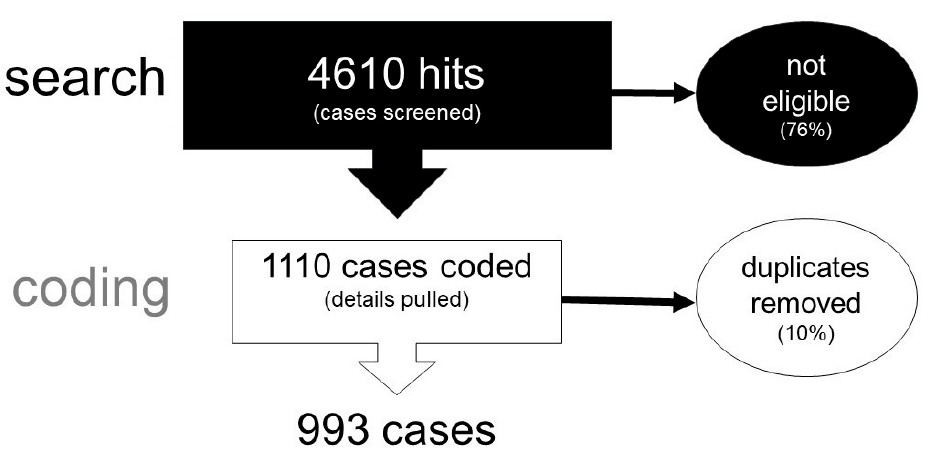
Figure 3. Case Identification Protocol.